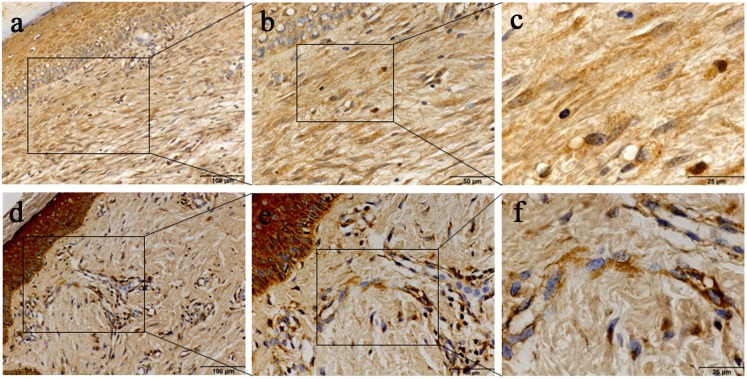
Immunohistochemical analysis of IL-10Rα expression in HS and NS tissue.Streptavidin-peroxidase DAB staining showed that IL-10Rα was localized in HS tissue (a–c) and NS tissue (d–f). IL-10Rα was distributed on the cell membrane and in the cytoplasm, with more intensive staining in NS (d–f) than in HS tissue (a–c). Scale bars, a and d, 100 µm; b and e, 50 µm; c and f, 25 µm.